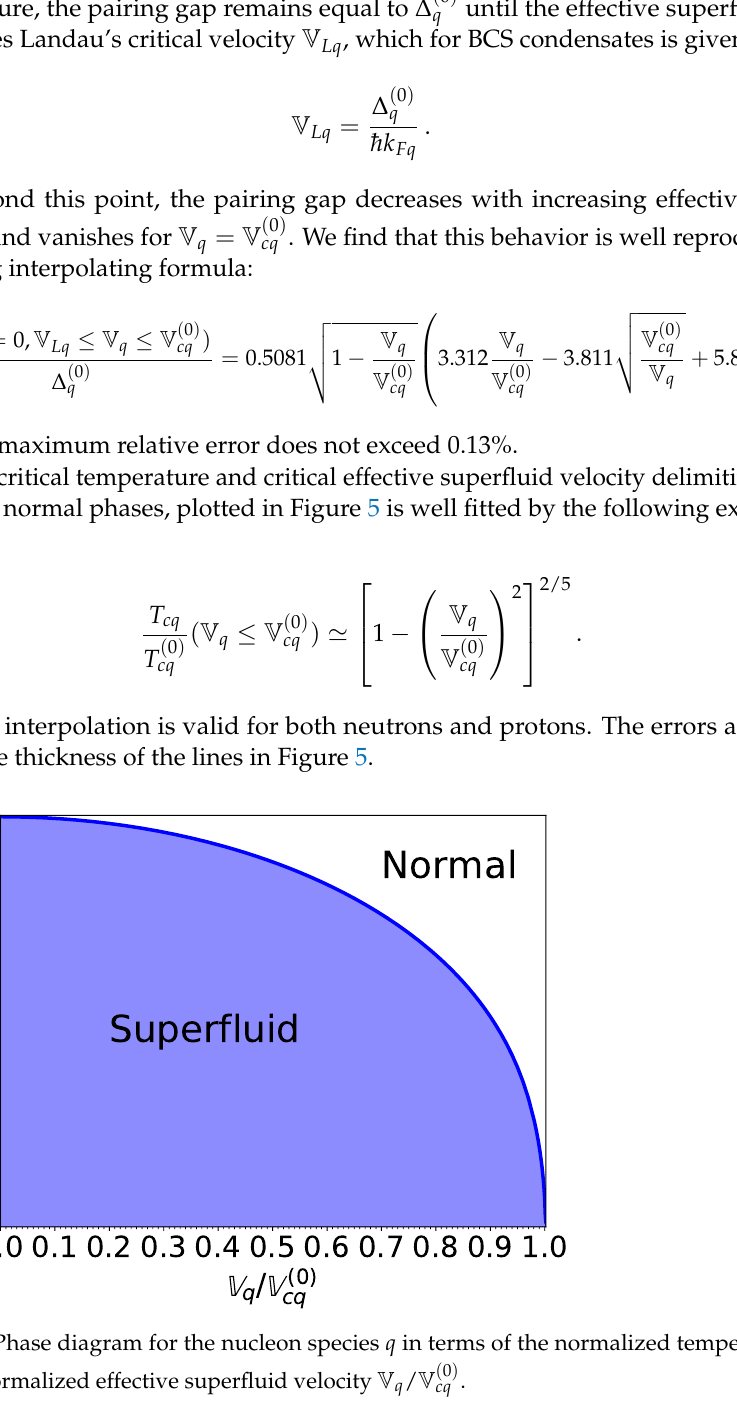
Figure 5. Phase diagram for the nucleon species q in terms of the normalized temperature T / T and the normalized effective superfluid velocity V q / V